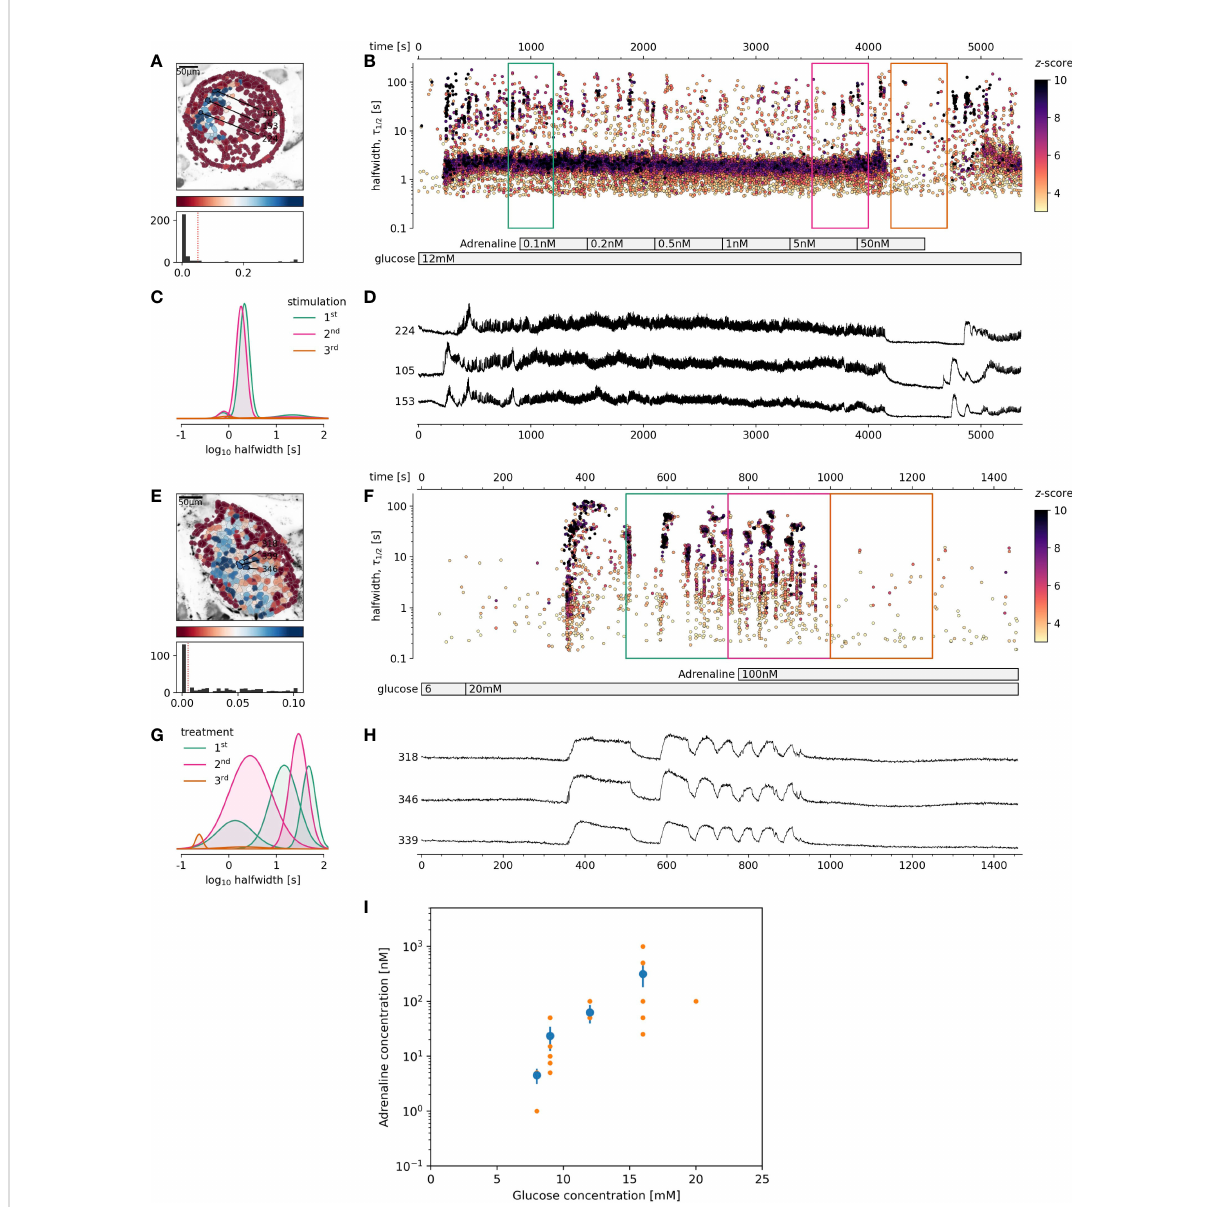
FIGURE 2 The effect of adrenaline on beta cell activity at supraphysiological glucose stimulation. (A-D) 12 mM glucose stimulation, (E-H) 20 mM glucose stimulation. (A, E) , Regions of interest (ROIs) obtained by our segmentation algorithm. The color indicates the number of events identi fi ed in the ROI trace, upon a high-pass fi ltering at 0.2Hz. We discarded ROIs with number of events below the threshold (red dashed line in the histogram in the lower panel). Indicated are the ROI numbers whose fi ltered traces correlate best with the average trace for the whole islet. (B, F) , Events ’ halfwidth duration through time. Note the ranges of halfwidth duration occurring, the events ’ synchronicity, and a concentration-dependent increase in frequency and halfwidth duration of [Ca 2+ ] c events. Color indicates the statistical signi fi cance in terms of z -score as indicated. The treatment protocol is indicated in the bar at the bottom of the pane. (C, G) , Normalized Gaussian fi t through the logarithmic distribution of halfwidth duration, indicated temporal summation producing 3 discrete modes in beta cells. (D, H) , Time courses from ROIs indicated in (A, E) , exposed to an increasing concentration of adrenaline, and rebinned to 2Hz (recorded at 20Hz). (I) , Adrenaline concentration-dependent inhibition of glucose-dependent activation of beta cell collectives. The mean of islet means +/- SEM (blue dots and lines), and individual islet means (orange dots). The number of islets used for the plot was 10, 8, 8, 9, 1 for 8, 9, 12, 16 and 20 mM glucose, respectively. One-way Anova, followed by a Bonferroni correction for multiple tests revealed the differences at the level below 0.001 between 8 mM glucose and both 12 and 16 mM